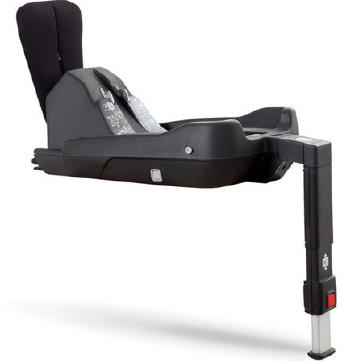
Figure 2: IQ ISOfix base for attaching child seats